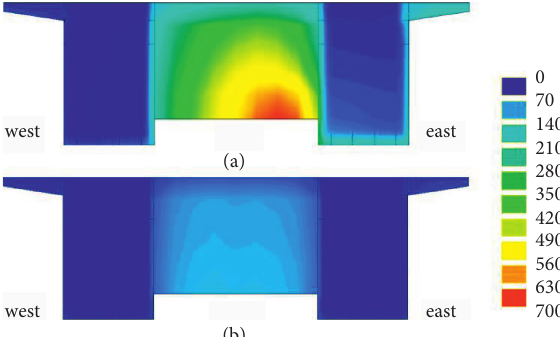
Figure 9: Isotherm of S-type diaphragms at failure: (a) diaphragm 1.25m from bridge centerline; and (b) diaphragm 6.25m from bridge centerline (unit: °